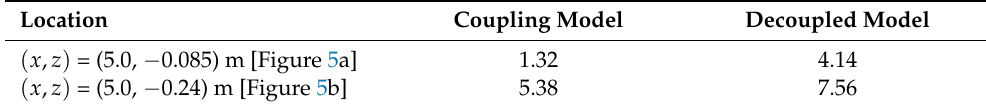
Table 2. Comparison of the RMSE of the present coupling model and decoupled model [18] with experimental data